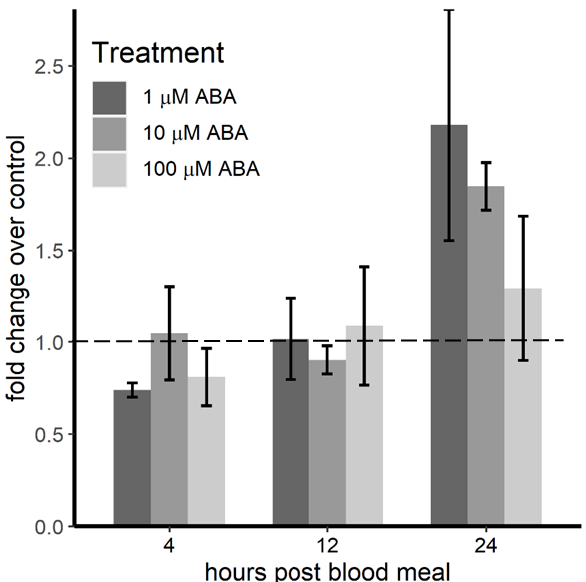
Figure 4. ApoLp-III transcript expression in P. y. yoelii 17XNL-infected A. stephensi derived from control and ABA-treated larvae did not di ff er through 24 h post-infection. For these studies, 3–5 day old female mosquitoes were used for infection and analysis of apoLp-III expression. Transcript levels were quantified by qRT-PCR using the 2 – ∆∆ Ct method; controls (0 µ M ABA) were set to 1 (dashed line). Relative to controls, there were no significant di ff erences in apoLp-III expression at 4 h ( F = 0.641, p = 0.610), 12 h ( F = 0.085, p = 0.966) or 24 h ( F = 1.377, p = 0.318) post-infection in females derived from larvae treated with 1, 10 or 100 µ M ABA. Data were analyzed by ANOVA and are shown as mean ± SE for three biological replicates with separate cohorts of A. stephensi .